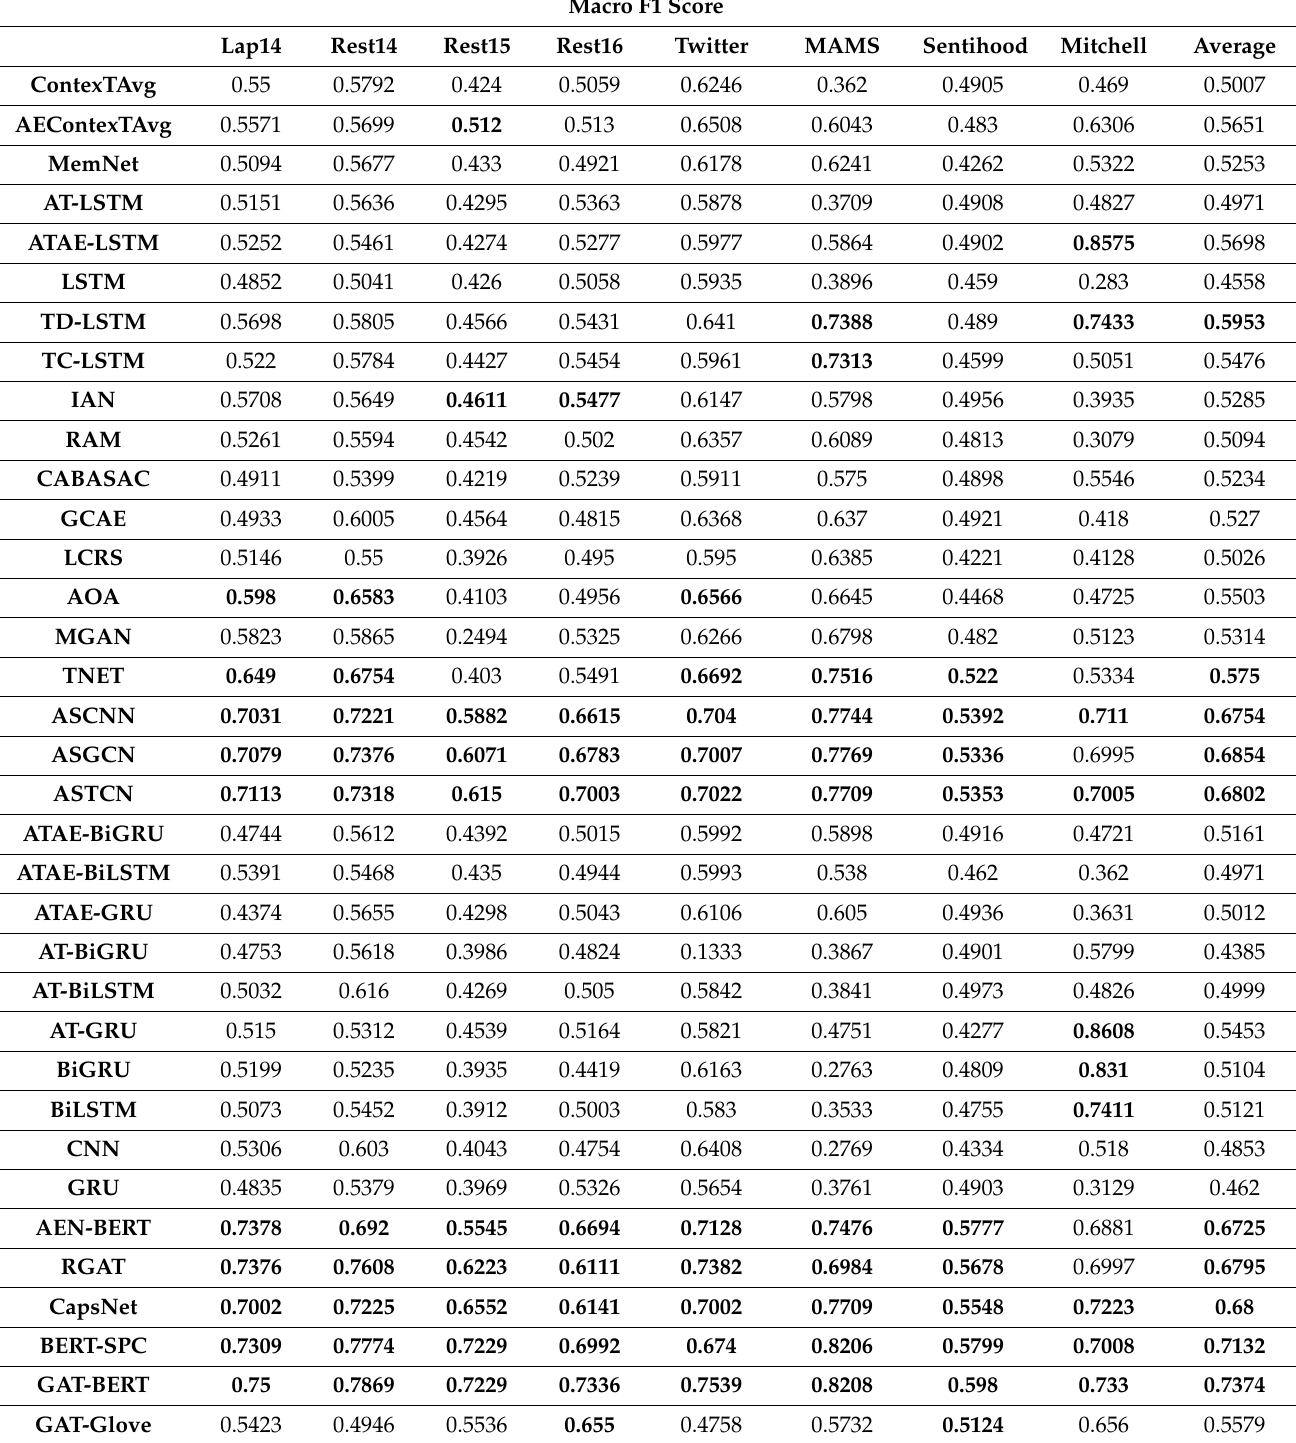
Table 4. Experimental results for Macro-F1 score in our